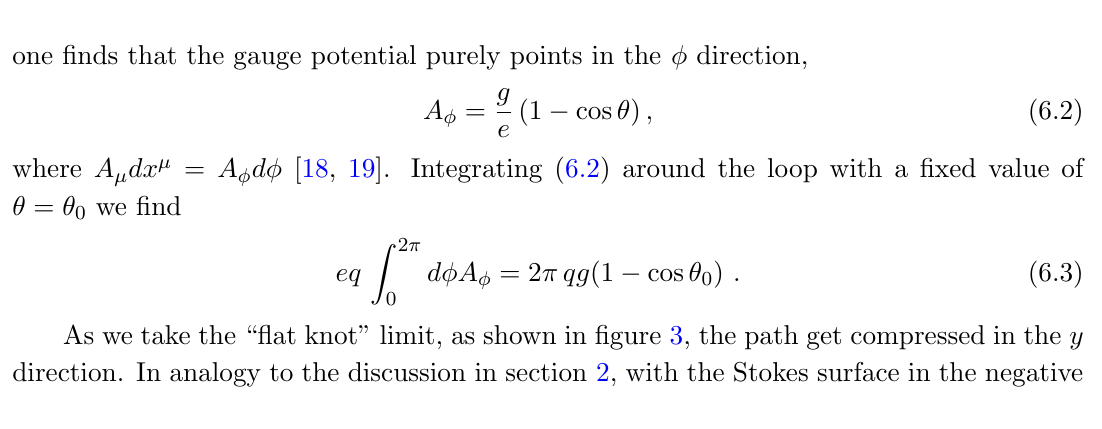
Figure 3 . Aharonov-Bohm trajectory in the \(cid:13)at knot" limit where a charged particle (solid line with arrows) encircles a Dirac string (dashed line) which lies along the positive x -axis. A time-ordered sequence of points is labeled